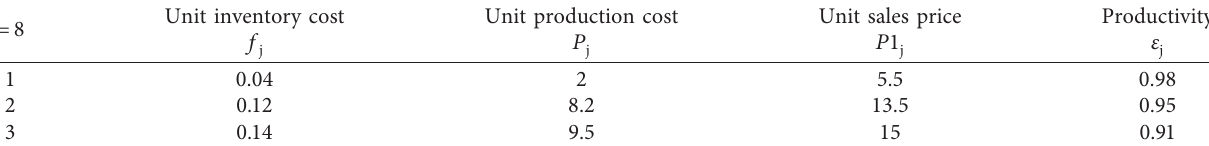
Figure 1: Supply process of agricultural superdocking. Table 1: Data table of farmers’ professional cooperatives.